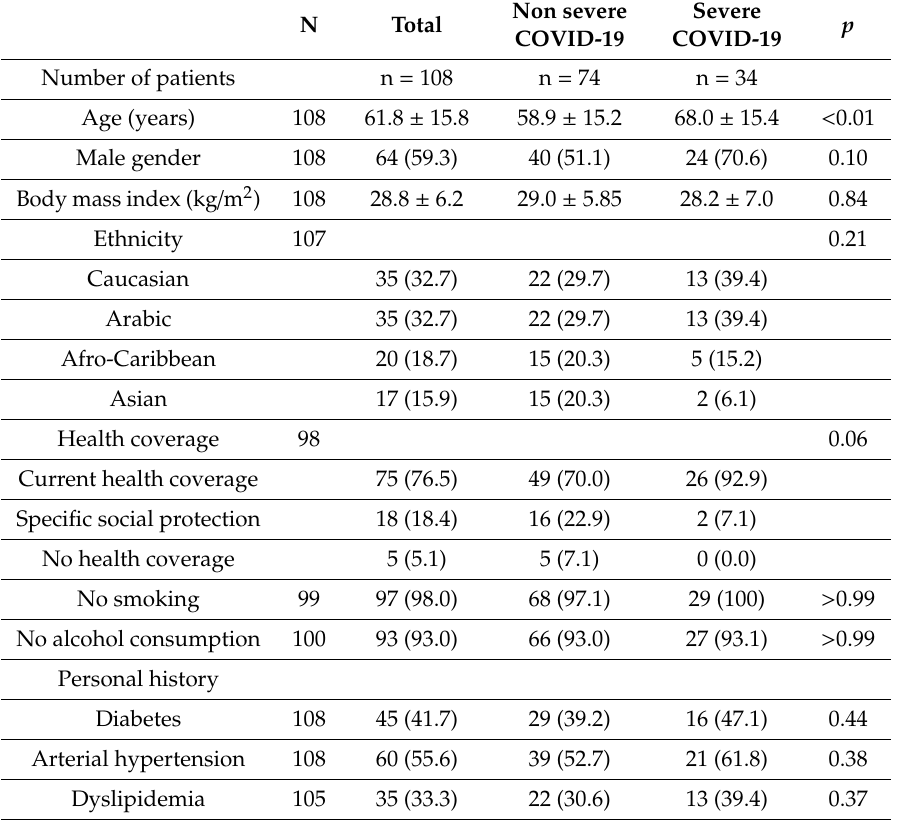
Table 2. The mean delay between admission and the onset of symptoms was 7.6 ± 5.3 days. Table 1. Population characteristics at